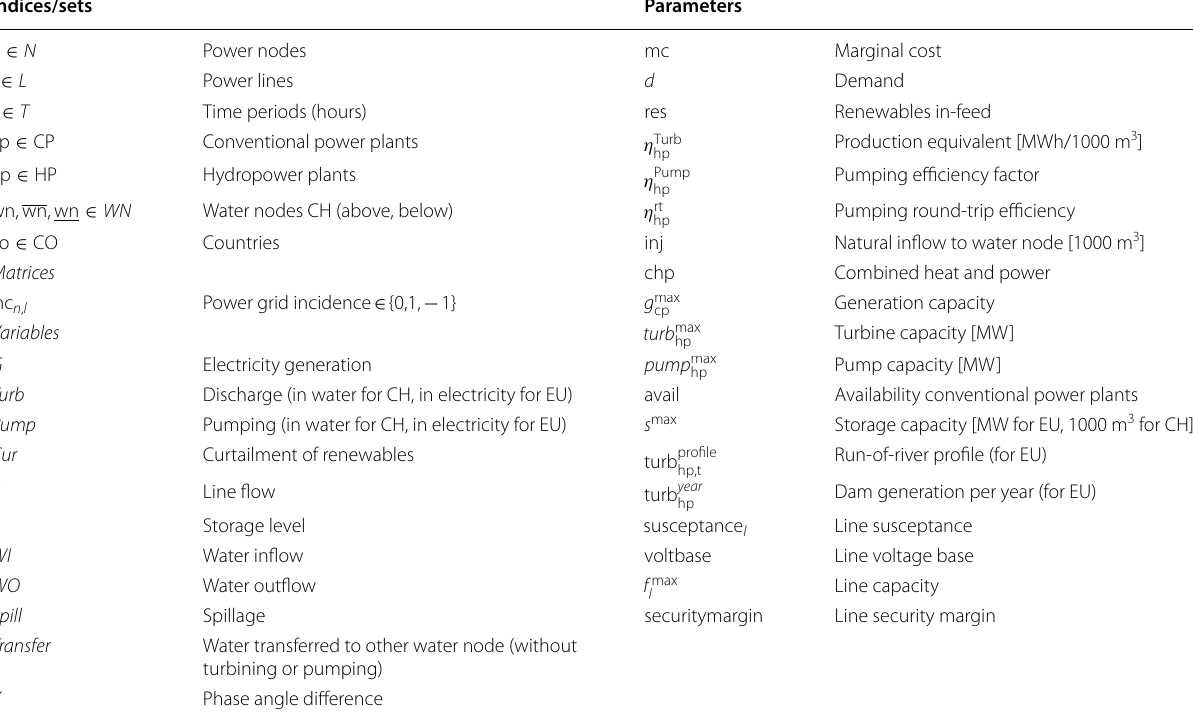
Table 6 Notation used for the Swissmod model